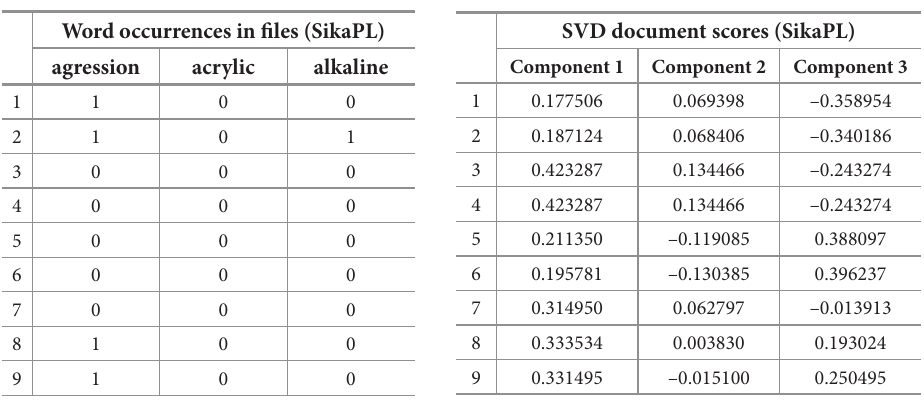
Fig. 7. BOW matrix (fragment) Fig. 8. SVD matrix (fragment)